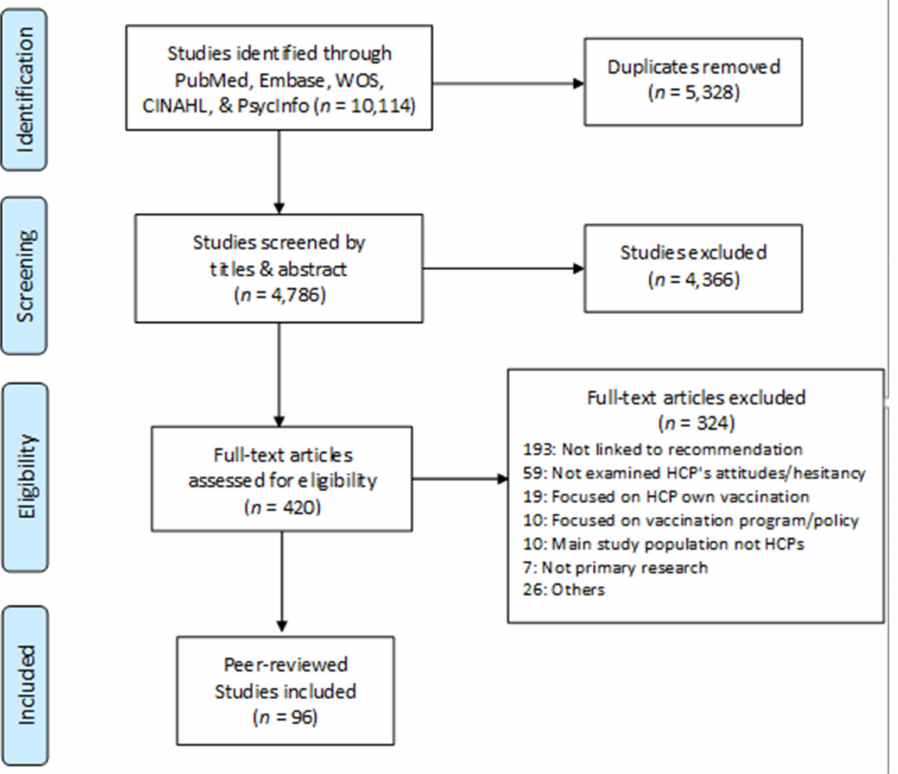
Figure 1. PRISMA Flow Diagram of study search and